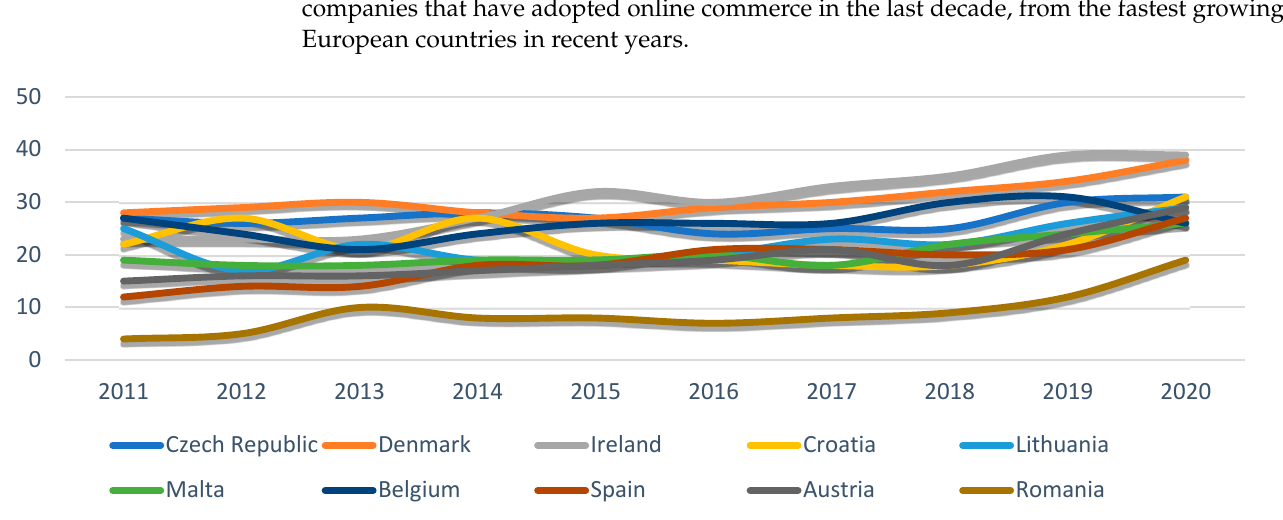
Figure 6. Evolution of online sales of European companies. Therefore, online sales have increased year by year in most European countries, with decreases in some periods but then continuing a rapid evolution. Among the biggest increases in online commerce were the Czech Republic and Denmark, starting at 27% and 28%, respectively, in 2011 and reaching 39% in the Czech Republic and Denmark at 38%. On the other hand, the country with the slowest evolution was Romania, starting from 4% in 2011 and reaching only 19%, compared to other European countries, which reached over 25% by 2020. In addition, in terms of the evolution of online business-to-business (B2B) sales, through the delivery of products and services from one company to another, Ireland has seen the biggest evolution over the last decade, starting at 23% in 2011 and continuing up to 39% [48,49]. In terms of the evolution of B2B online sales, Denmark is similar to Ireland, starting at 28% in 2011 and continuing to grow to 38% in 2020 (Eurostat, 2020). At the same time, countries such as the Czech Republic, Croatia, Lithuania, Malta, Belgium, Spain, and Austria have made clear progress, reaching over 25%. Romania has evolved in the same way as the other countries, but the course has been much slower. It started at 4% and continued to grow to 19% in 2020, so the last year’s increase was caused by the COVID-19 pandemic, when states of emergency were declared in the territory of the country and among consumers [50,51]. Companies have also opted for the online version of the trade, proving to be much more satisfactory, see Table 6. Table 6. Evolution of enterprise B2B online sales (percentage